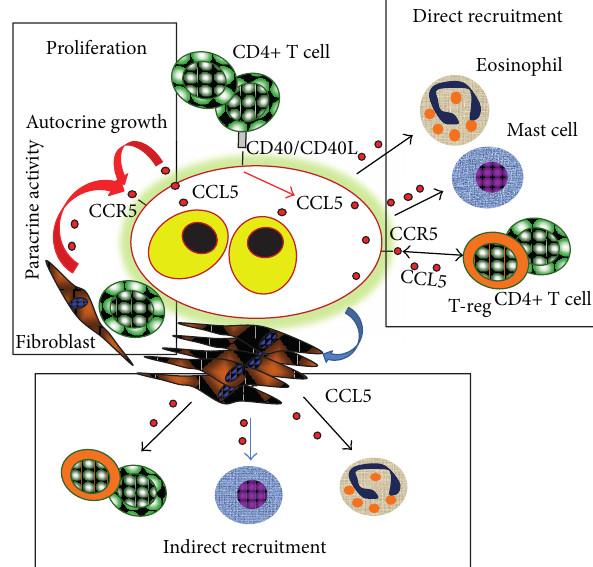
Figure 2: Interactions among cHL cells and the microenvironment. Proposed role of the CCL5/CCR5 axis in Hodgkin Lymphoma lead- ing to tumor cell proliferation and microenvironment formation. CCL5 produced by cHL cells may represent an autocrine growth factor. CCL5 secreted by T cells or fibroblasts may represent a paracrine growth factor. CD40L increases CCL5 secretion by cHL cells and they induce fibroblasts to secrete CCL5. CCL5 secreted by cHL (direct recruitment) or fibroblasts activated by HL cells (indirect recruitment) may in turn recruit CD4+ T cells, T-reg cells, eosinophils, and mast